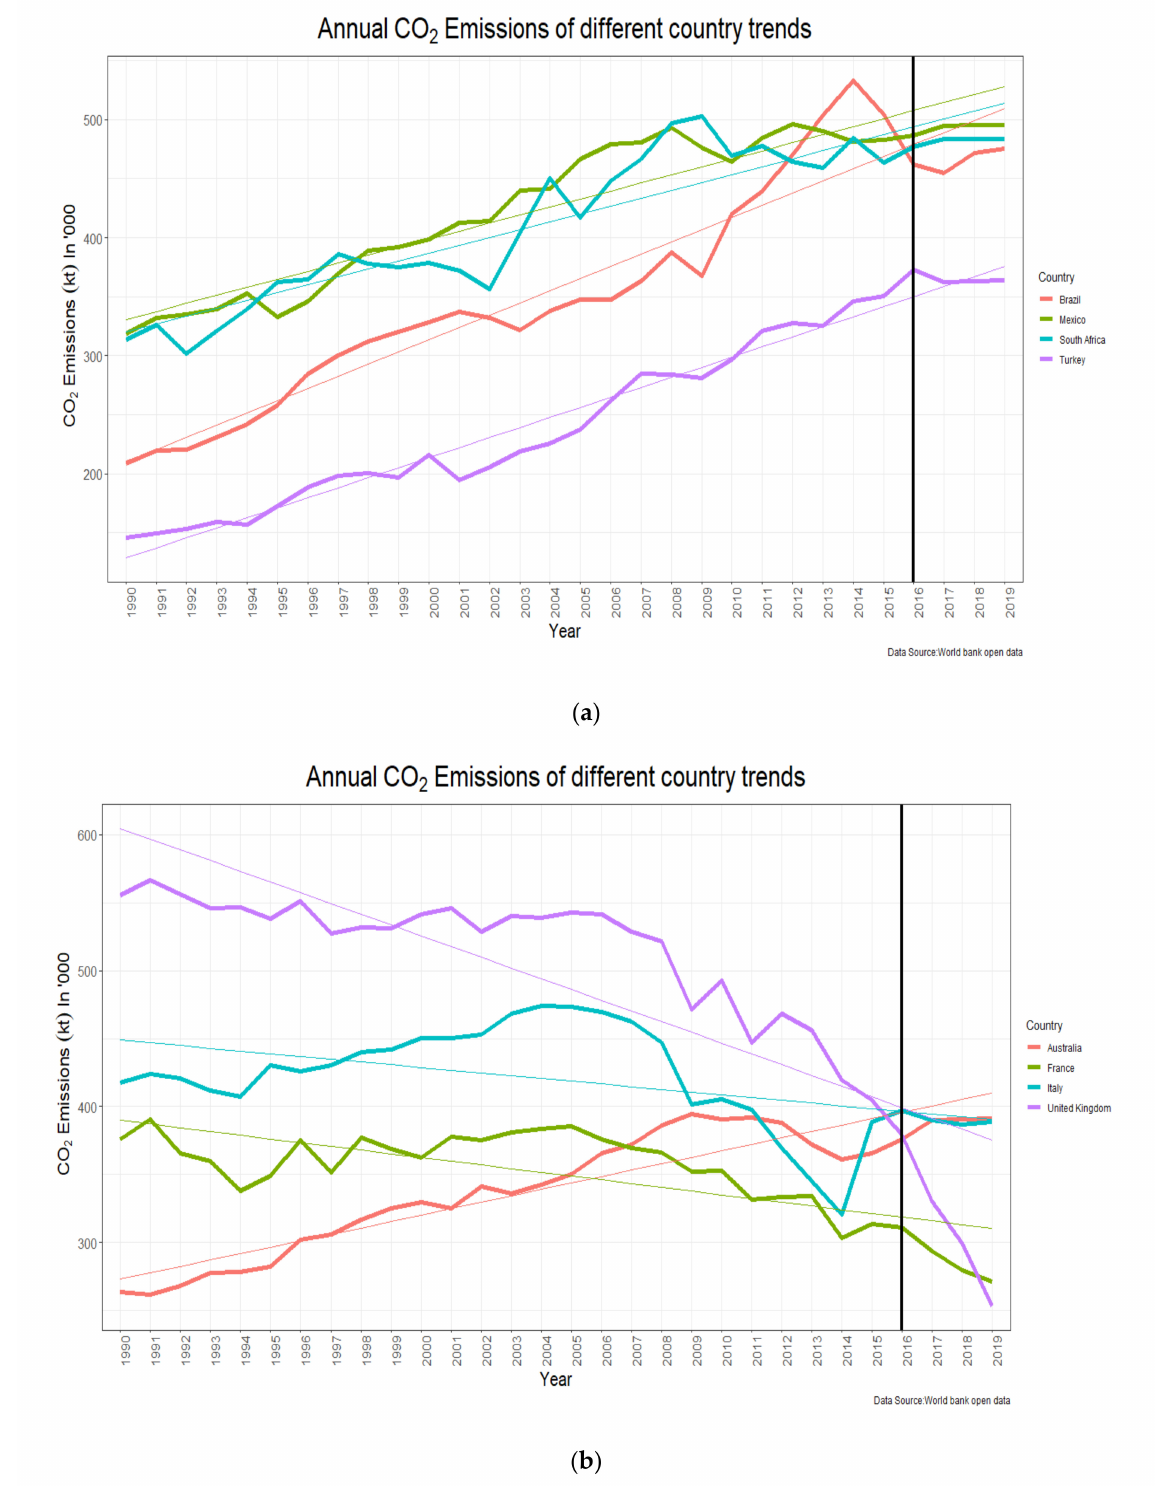
Figure 9. The actual and forecasted CO 2 emissions values for countries: ( a ) Brazil, South Africa, Mexico, and Turkey; ( b ) Australia, UK, Italy and